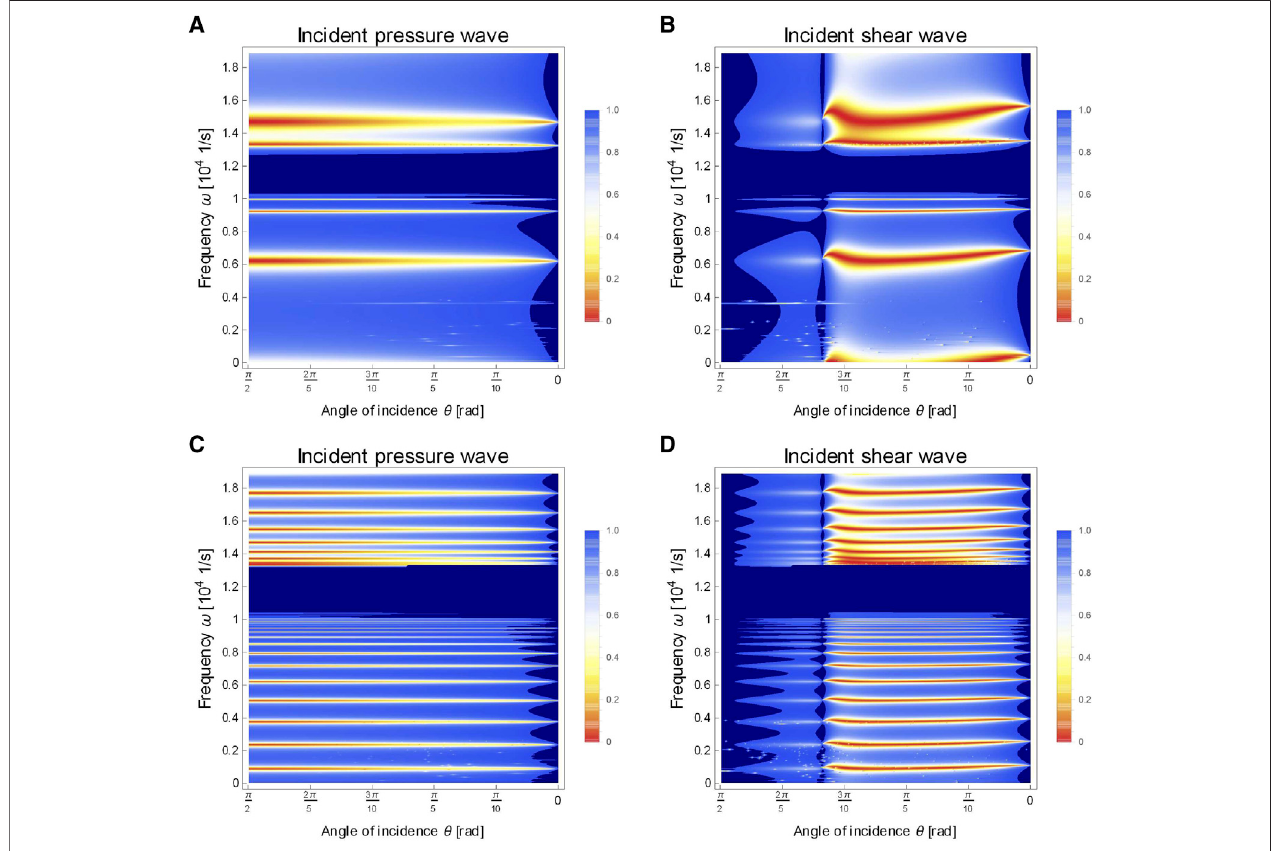
FIGURE13| Simulationofthere fl ectioncoef fi cientwiththeobtainedrelaxedmicromorphicmodelfora20 (A,B) anda100 (C,D) unitcellsthickslabmadeupof MM1 materialandembeddedin CM1 Cauchyasfunctionoftheangleofincidenceandofthewave-frequency – (A) and (C) :incidentpressurewave; (B) and (D) incidentshearwave.